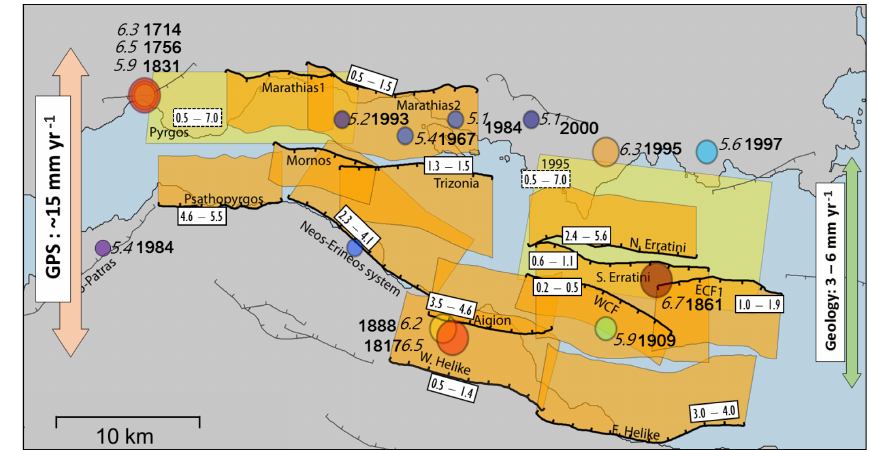
Figure 2. Map of the active faults of the western part of the Corinth rift (modified from Boiselet, 2014). The orange polygons are the surface projection of the active faults. The yellow polygons are the surface projection of the blind faults (Pyrgos fault and 1995 fault). Earthquakes of the catalog during the complete period are represented by circles with color and size depending on the magnitude. The date and magnitude of earthquake are indicated. The minimum and maximum values (mmyr − 1 ) of the slip rates of the faults are indicated in the white boxes. The green arrow shows an approximation of the rift extension calculated by projecting horizontally the faults’ slip rate, and the pink arrow shows the extensional rate of the rift measured by